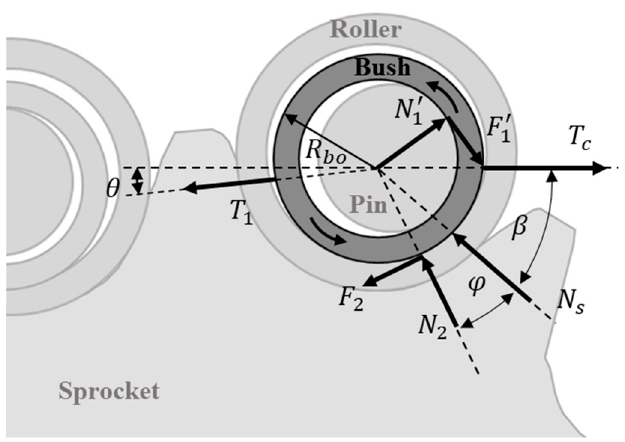
Figure 4. Schematic of contact for bush articulation.